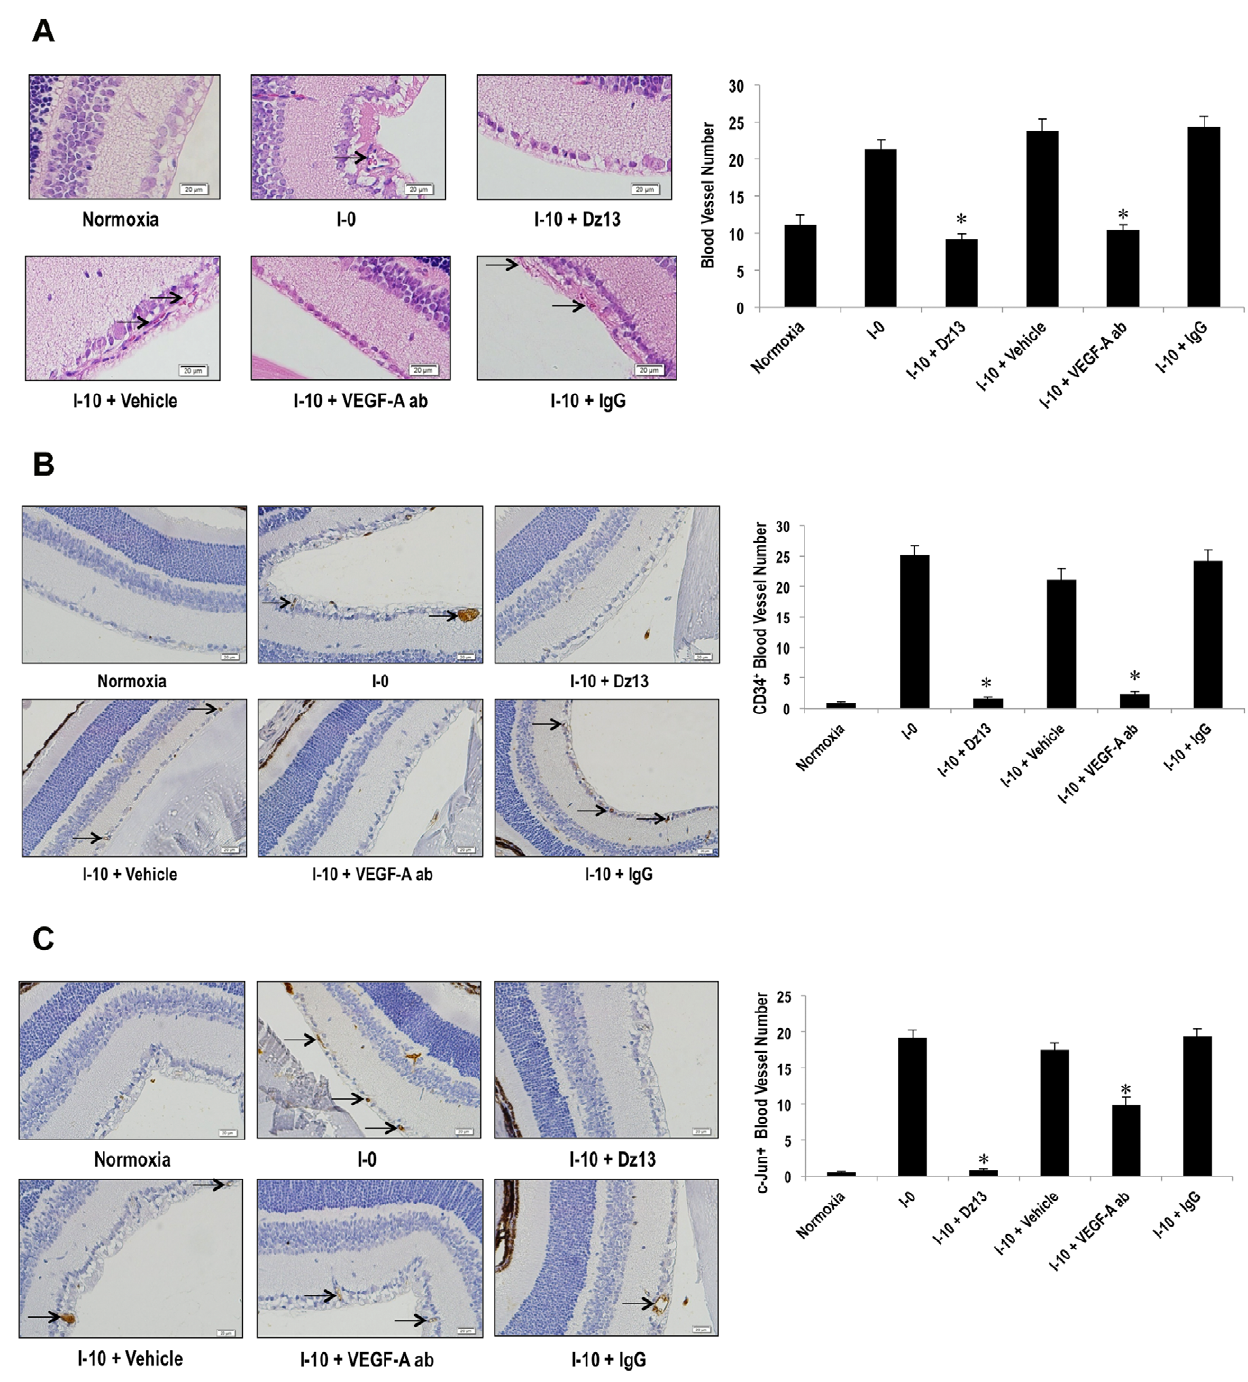
Figure 4. Comparison of Dz13 with VEGF-A antibodies in the modified OIR model. ( A ) C57BL/6 mice (I-0) were injected with Dz13 (20 m g) in DOTAP/DOPE or its vehicle control (H 2 O containing DOTAP/DOPE), VEGF-A antibodies (10 m g/ m l) in PBS, pH 7.4 or IgG (10 m g/ m l) in PBS, pH 7.4 and eyes removed at I-10. VEGF-A antibody concentration was as per Ref [23]. Blood vessels on the vitreal side of the inner limiting membrane were quantified by counting erythrocyte-filled vessels in H&E-stained sections ( A ), CD34-stained sections ( B ) or c-Jun-stained section ( C ). ‘‘Blood vessel number’’ represents the mean number of blood vessels in 3 parallel cross-sections (5 m m each) per retina at 3 distances from the optic nerve (0, 50, 100 m m). n=6–8 eyes per group. Blood vessels are denoted by arrows. *denotes P , 0.05 relative to vehicle or IgG. doi:10.1371/journal.pone.0039160.g004 and migration, cellular processes that underpin retinal neovascu- OIR model used in a curative setting here contrasts with Dz13’s larization. This study also provides the first evidence that prevention of retinal angiogenesis [20]. The fact that GSEA intravitreal administration of a DNAzyme confers a behavioral suggests that cancer-related gene sets are downregulated by Dz13 advantage to mice through forepaw extension. Such testing takes is consistent with Dz13 inhibition of endothelial cell proliferation